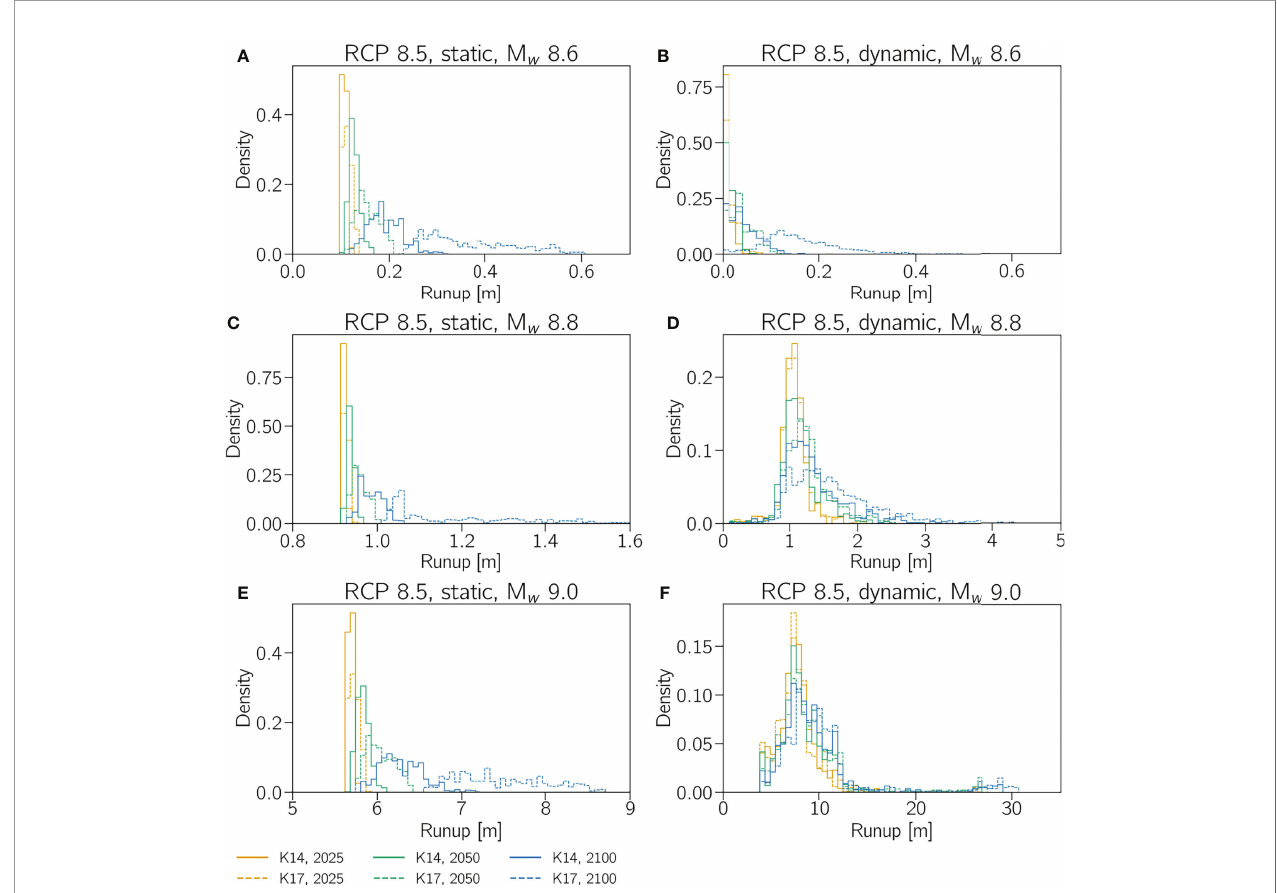
FIGURE 5 | Probability densities of run-up for M w 8.6, 8.8, and 9.0 for RCP 8.5 for the static bathymetry (A, C, E) and dynamic bathymetry (B, D, F) for K14 and K17 for the years 2025, 2050, and 2100. Note that the ranges of the x-axes were chose to highlight the nearly order of magnitude differences between (A, C, E) , and (B, D, F)